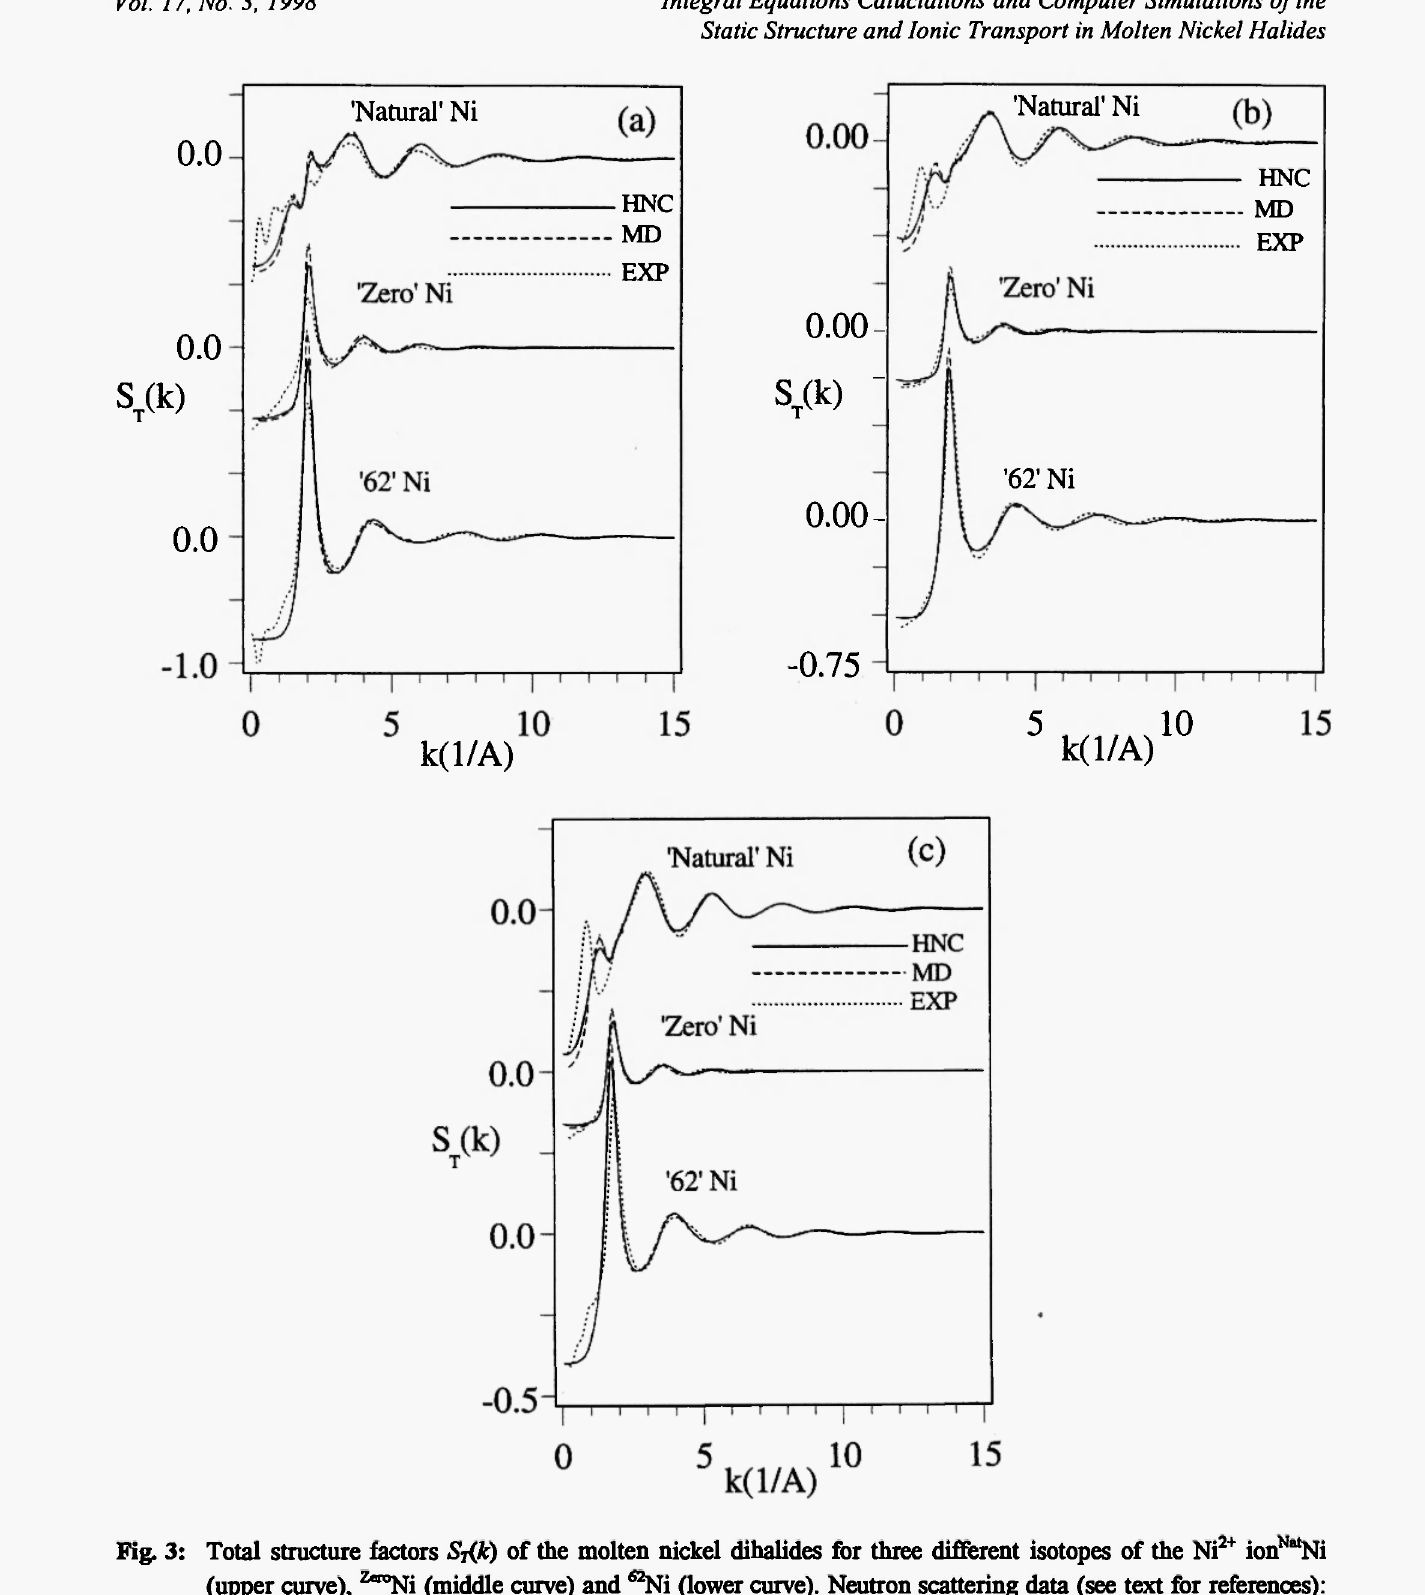
Fig. 3: Total structure factors Sj(k) of the molten nickel dihalides for three different isotopes of the Ni 2+ ion Nal Ni (upper curve), Zero Ni (middle curve) and 62 Ni (lower curve). Neutron scattering data (see text for references): dotted lines; MD: dashed lines; HNC: solid lines, (a) molten NiCl